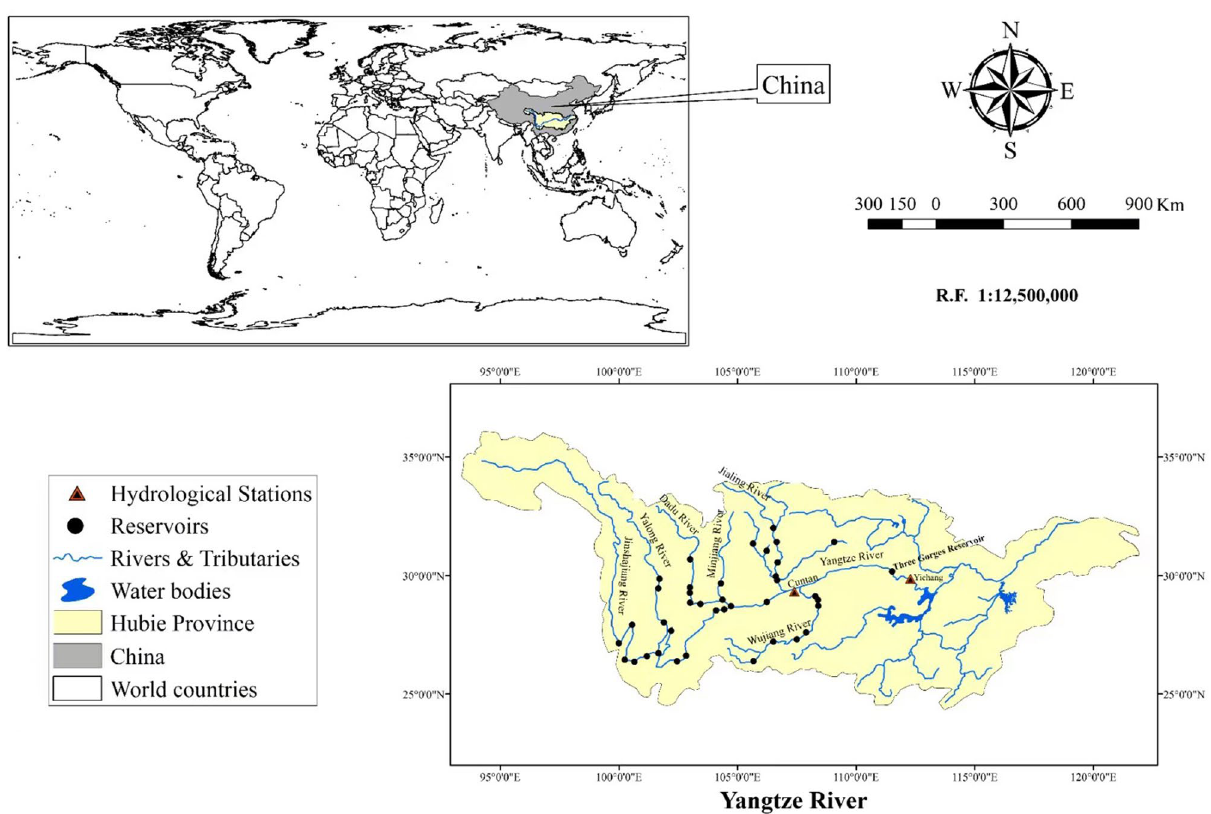
Fig. 2 The Map of Yangtze